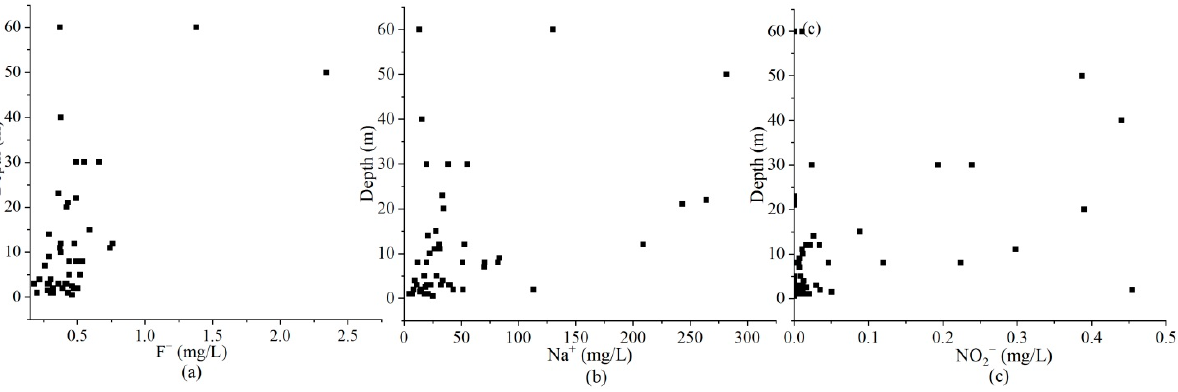
Figure 3. Relationship between fluoride and depth ( a ), sodium and depth ( b ), nitrite and depth ( c